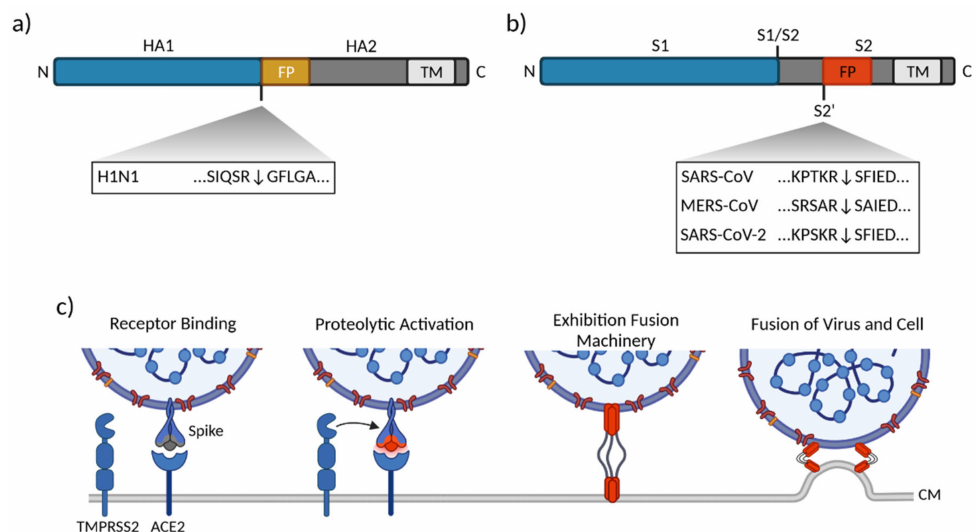
Figure 3. Schematic representation of ( a ) influenza virus hemagglutinin (HA) and ( b ) coronavirus spike (S) glycoproteins. FP: fusion peptide, TM: transmembrane domain. Downward arrows indicate TMPRSS2 cleavage sites. Sequences derived from Uniprot Q9WFX3 (H1N1); P59594 (SARS-CoV); A0A023SFE5 (MERS-CoV); P0DTC2 (SARS-CoV-2). ( c ) Schematic representation of SARS-CoV-2 entry mediated by TMPRSS2. Figure created with BioRender (accessed on 13 December